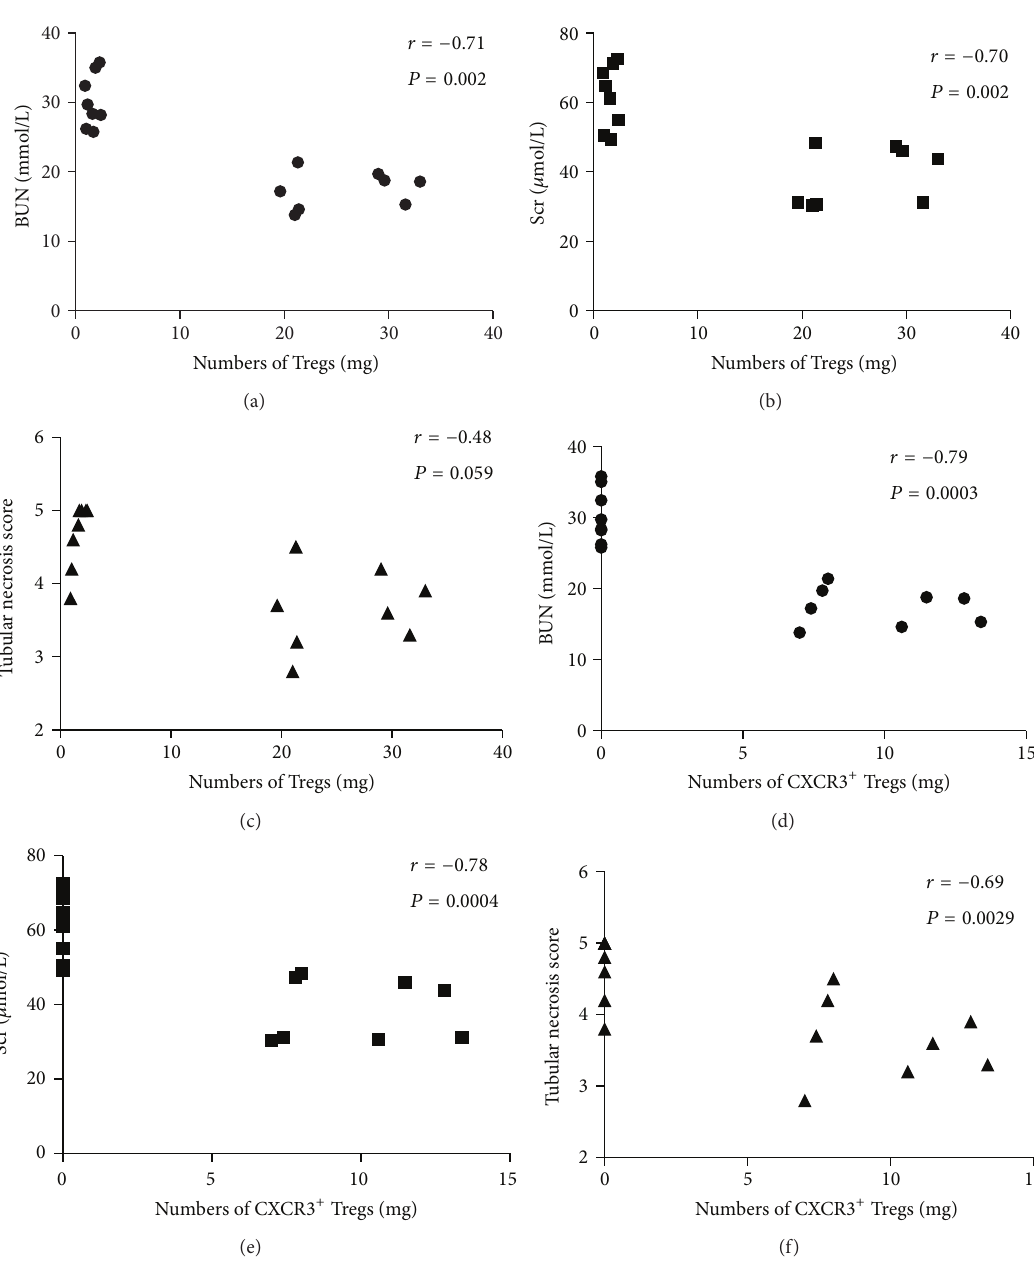
Figure 4: Correlation of CD4 + CD25 + Foxp3 + Tregs and CXCR3 + CD4 + CD25 + Foxp3 + Tregs with BUN, Scr, and tubular necrosis score in the IRI group. The numbers of CD4 + CD25 + Foxp3 + Tregs in the kidney were negatively correlated with BUN (a) and Scr (b) but not tubular necrosis score (c). The numbers of CXCR3 + CD4 + CD25 + Foxp3 + Tregs in the kidney were negatively correlated with BUN (d), Scr (e), and tubular necrosis score (f). Each symbol represents a single individual ( 𝑛 = 16